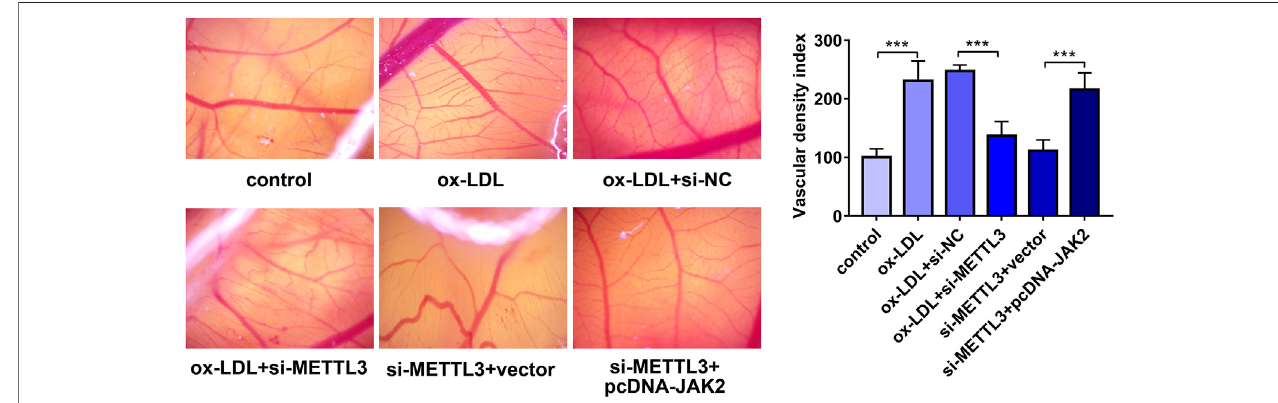
FIGURE 7 | METTL3 knockdown hindered ox-LDL-induced angiogenesis by regulating JAK2 in vivo . HUVECs were transfected with si-NC, si-METTL3, si- METTL3+vector, or si-METTL3+pcDNA-JAK2. Twenty-four hours later, HUVECs were stimulated with ox-LDL (10 μ g/ml) for an additional 24 h. Next, the conditioned medium was collected and added to the CAM (n (cid:1) 5). Three days later, the angiogenetic ability was assessed. *** p < 0.001.